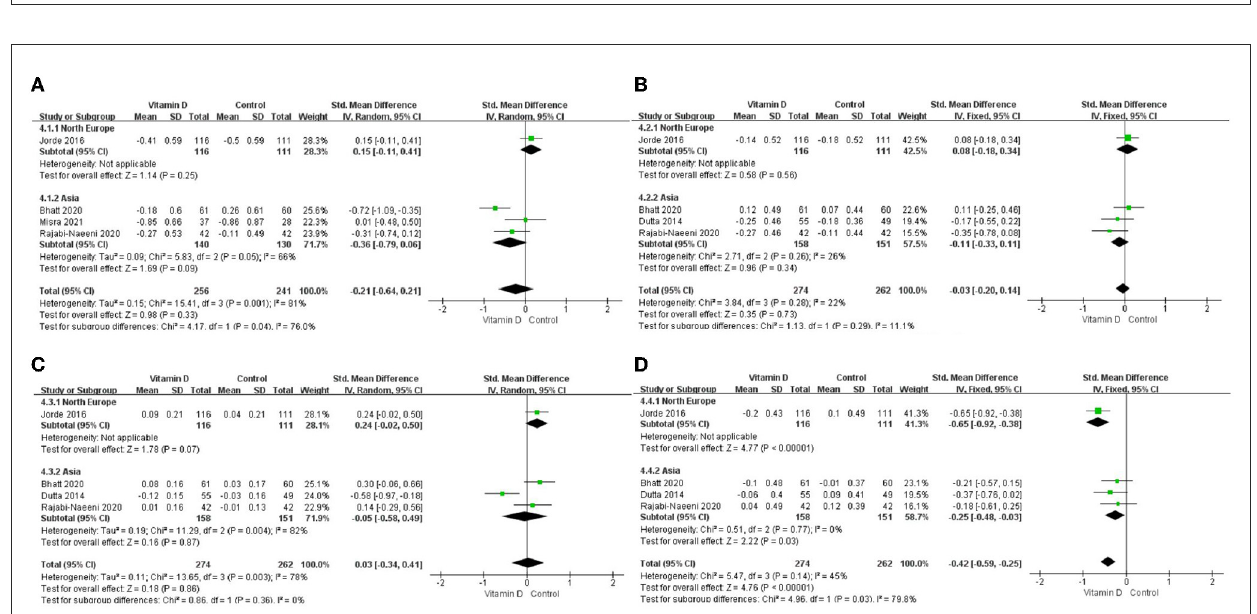
FIGURE5 Subgroup analysis by region. (A) TC, (B) LDL–C, (C) HDL–C, and (D) TG. TG. TC, total cholesterol; LDL-C, low-density lipoprotein cholesterol; HDL-C, high-density lipoprotein cholesterol; TG, triglyceride.